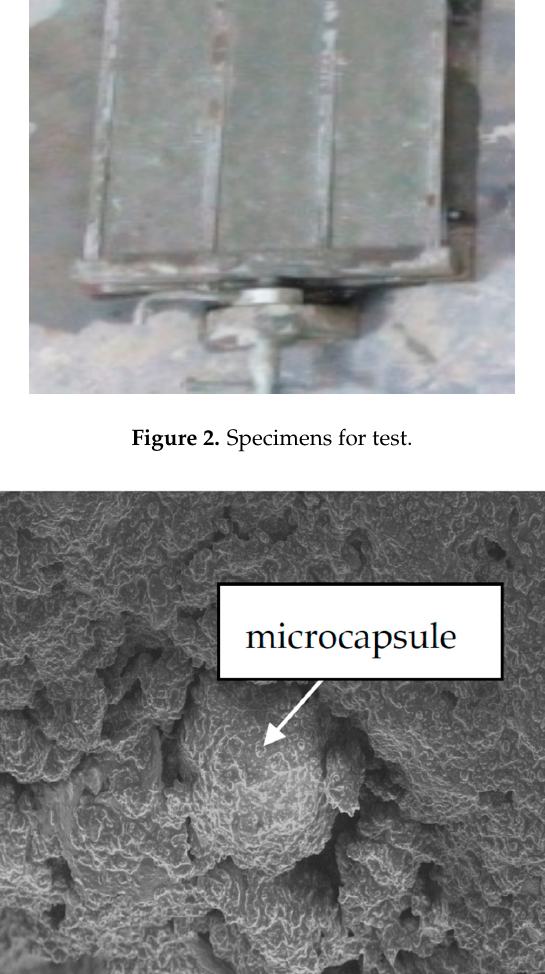
Figure 3. Microcapsules dispersed in the cementitious composite.